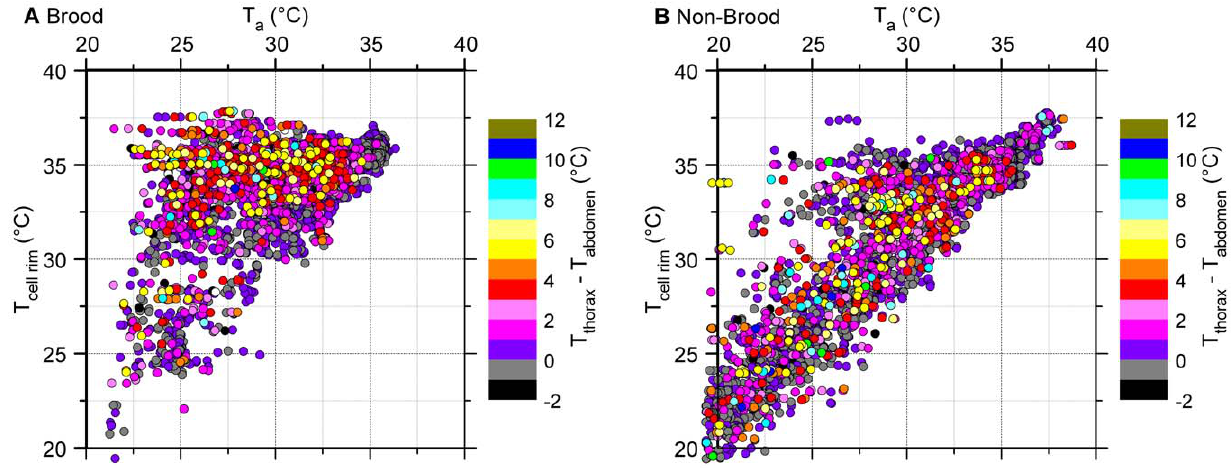
Figure 6. Intensity of endothermy (T thorax -T abdomen ) of bees on combs in relation to individual bees’ local ambient temperatures (T cell rim and T a ). See Fig. S1 for correlations between T cell base and T cell rim , and between T a and T exp .